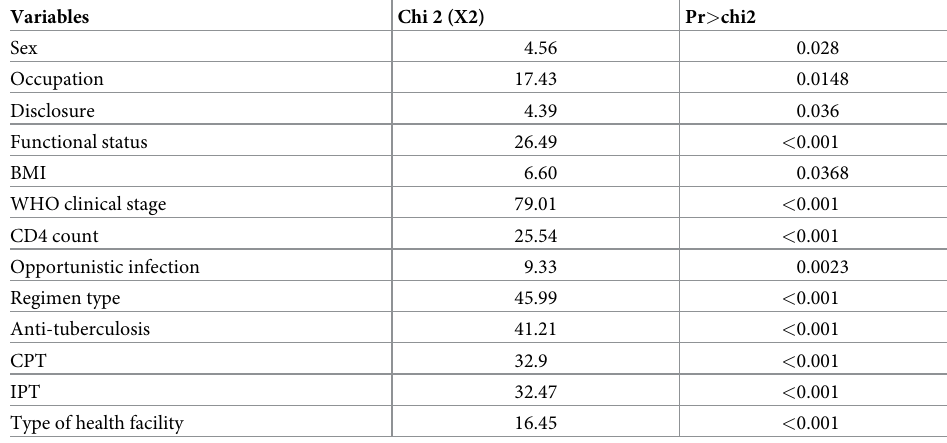
Table 6. Log-rank test for equality of survivor functions between categories of covariates.